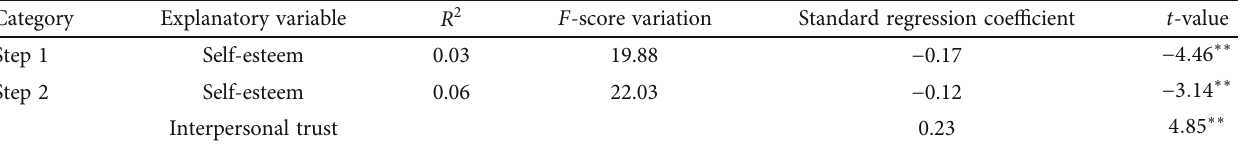
Table 3: Mediating e ff ect of interpersonal trust on the relationship between self-esteem and social anxiety.